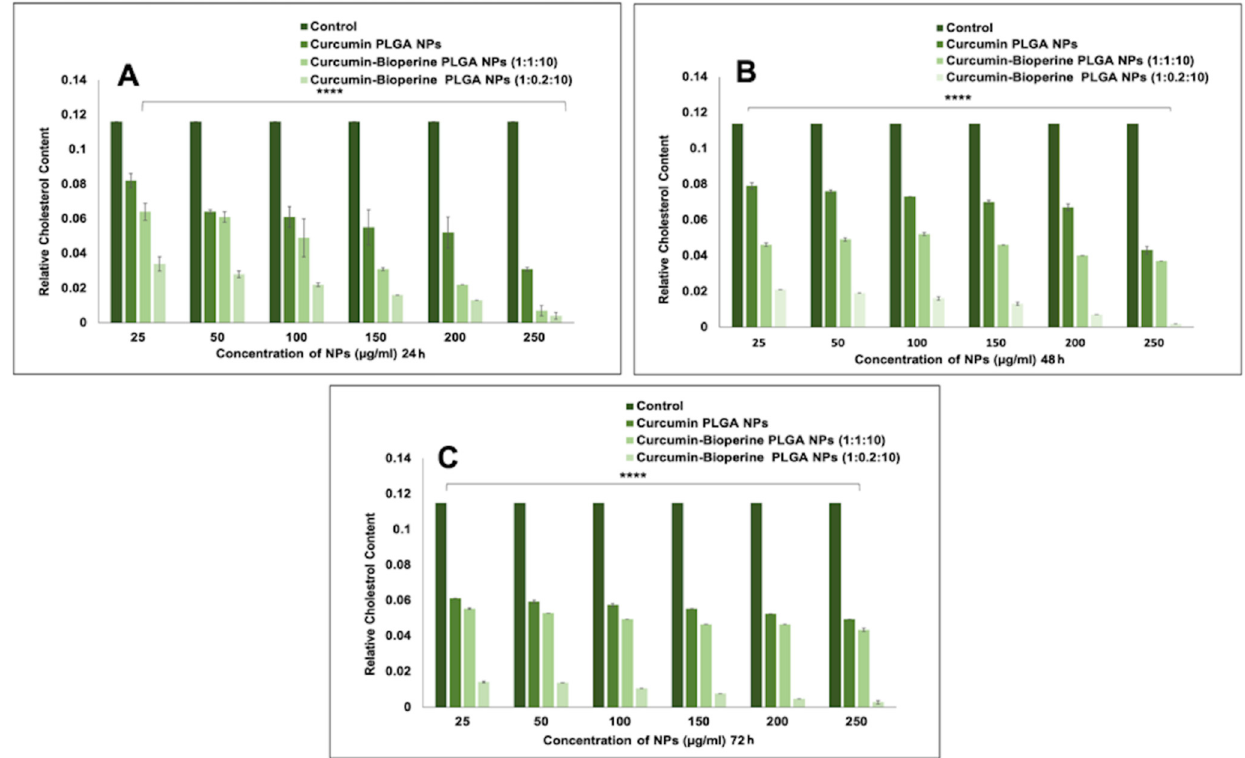
Figure 5. Relative cholesterol content of THP-1 monocyte-derived macrophage cells when treated with curcumin PLGA NPs, and both the ratios of curcumin-Bioperine PLGA NPs (1:1:10 and 1:0.2:10) for ( A ) 24 h ( B ) 48 h and ( C ) 72 h. (All the data for cholesterol quantitation studies are expressed as the mean ± S.E.M. Unpaired Student’s t -test was performed to check the statistical significance of the investigation using GraphPad Prism software. Data were considered significant when p < 0.05. Untreated samples were taken as controls). The cholesterol quantitation experiment demonstrated extremely statistically significant results, with p < 0.05 (**** p = 0.0001).